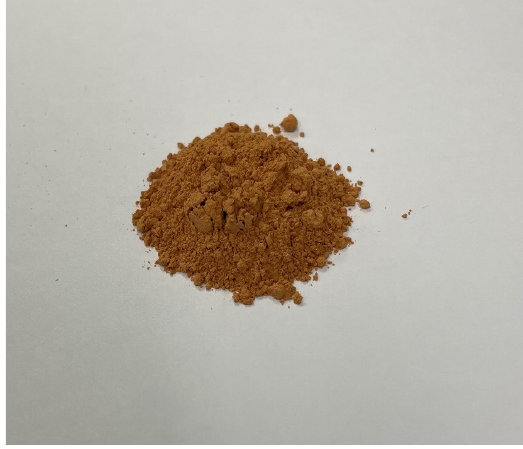
Figure 3. Non ‐ sintered hwangto. Figure 3. Non-sintered hwangto.